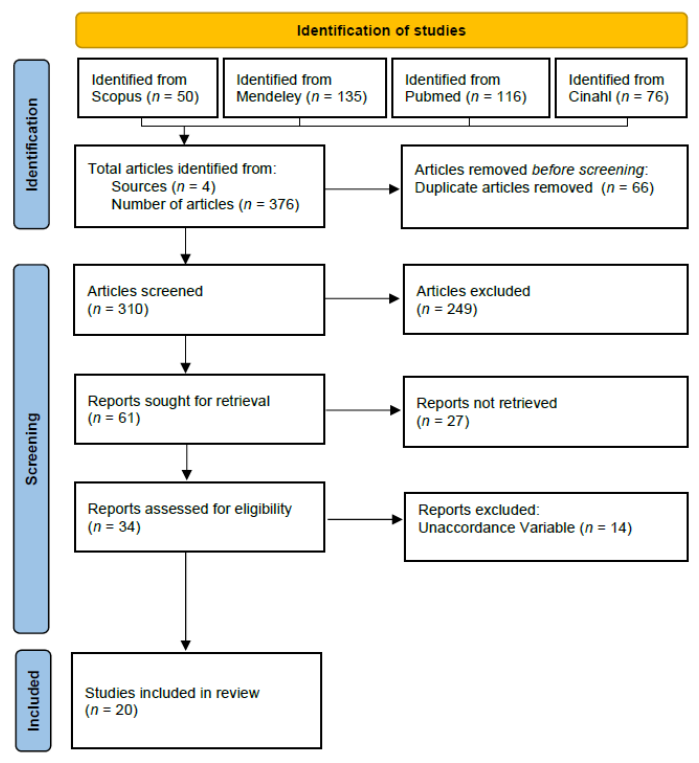
Figure 1. Prisma Flow Diagram .